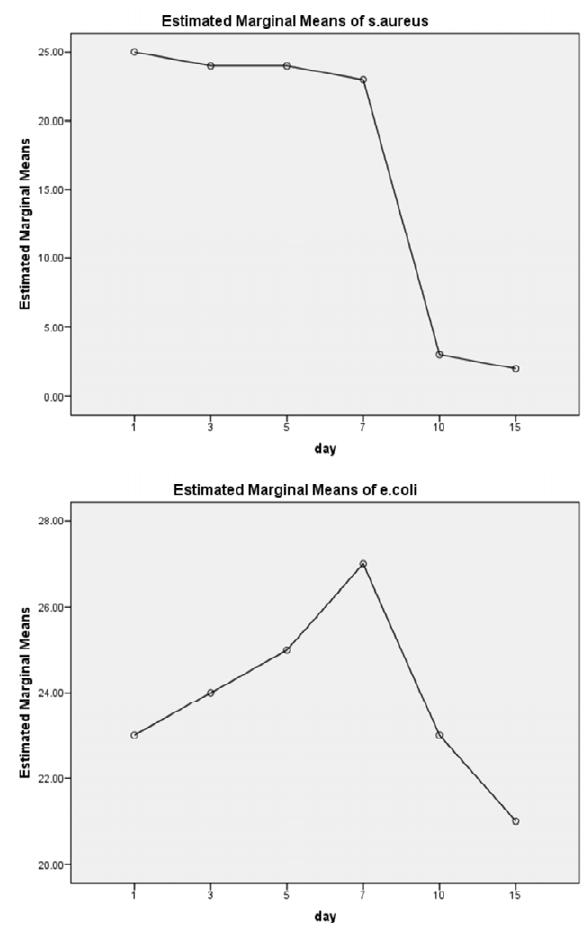
Fig. 2: Variations in inhibition zone diameter for S. aureus (ATCC25923) Figure 2: Variations in inhibition zone diameter for S. aureus (ATCC25923) and E. coli and E. coli (ATCC25922) as a function of CFX@PVA silk sutures in 15 days